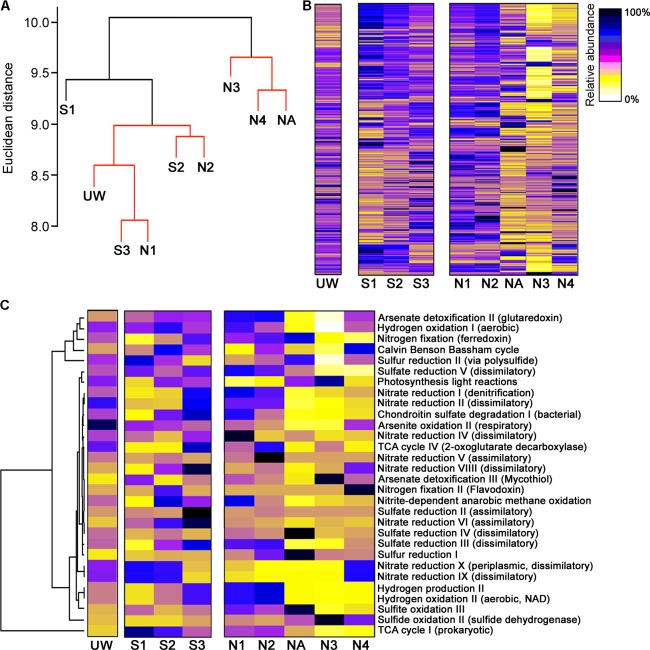
Metabolic prediction analysis and discrimination of sites on the basis of metabolic potential. (A) Hierarchical clustering of sample sites based on metabolic pathway similarity. Sites with non-significant clustering (p < 0.05) as determined by SIMPROF are indicated with red lines. Heat maps showing the predicted abundance of all prokaryotic metabolic pathways (B) and selected metabolic pathways related to element cycling (C).